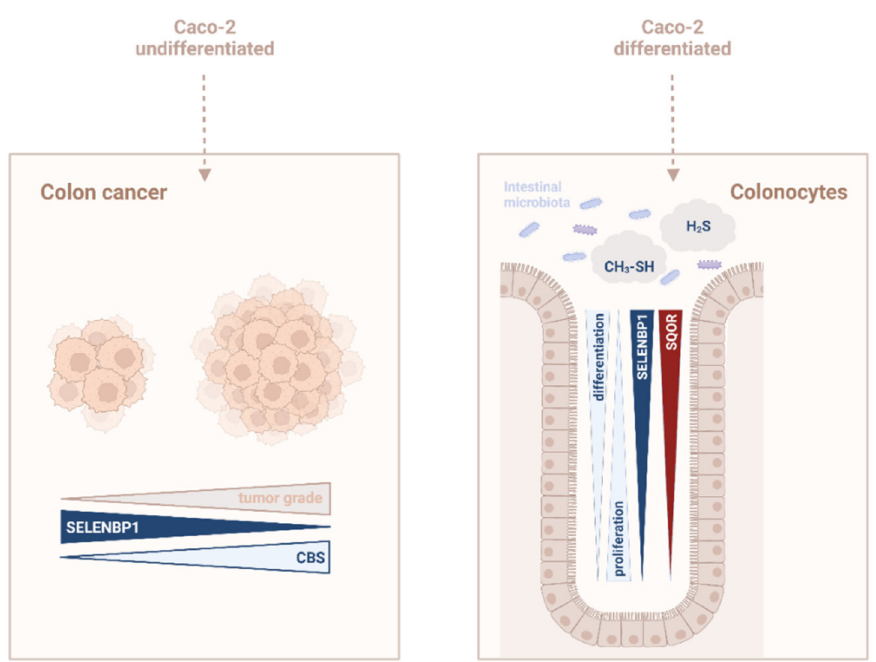
Figure 6. (Patho)physiological implications of changes in SELENBP1, CBS and SQOR levels in the course of CRC carcinogenesis and differentiation of intestinal epithelial cells. Left panel: The pattern of gene expression in undifferentiated Caco-2 cells parallels that of colon cancer. Elevated H 2 S levels, resulting from selective upregulation of CBS, have been found in human CRC biopsies, and were proposed to promote tumor growth. In contrast, SELENBP1 is largely suppressed in tumors. Right panel: Confluent Caco-2 cells cease proliferation and spontaneously differentiate to a colonocyte- like phenotype, associated with an increase in SELENBP1 and SQOR expression. High SELENBP1 and SQOR levels in mature colonocytes in vivo ensure the efficient catabolism of bacteria-derived methanethiol and H 2 S at the host–microbiome interface. Scheme created with Biorender.com. Butyrate exposure, while imitating some aspects of spontaneous differentiation, does not elicit the same expression patterns of genes encoding H 2 S-generating enzymes, particu- larly regarding CBS expression.